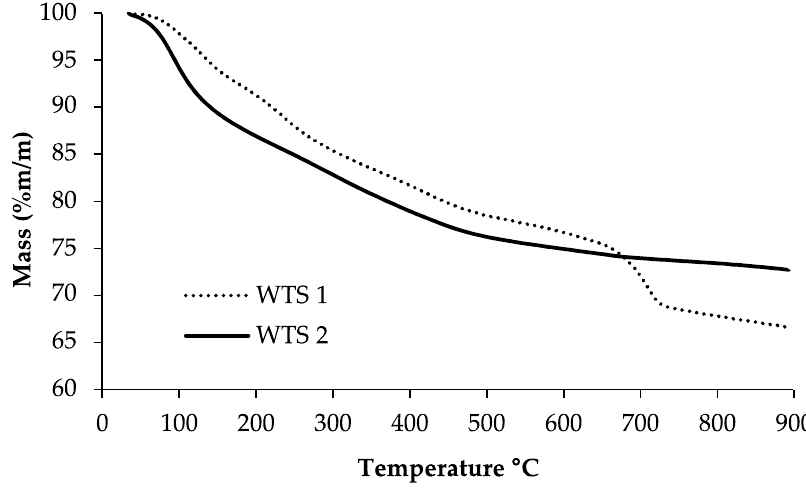
Figure 2. Thermogravimetric analysis (TGA) curves for the two water treatment sludges (WTSs)